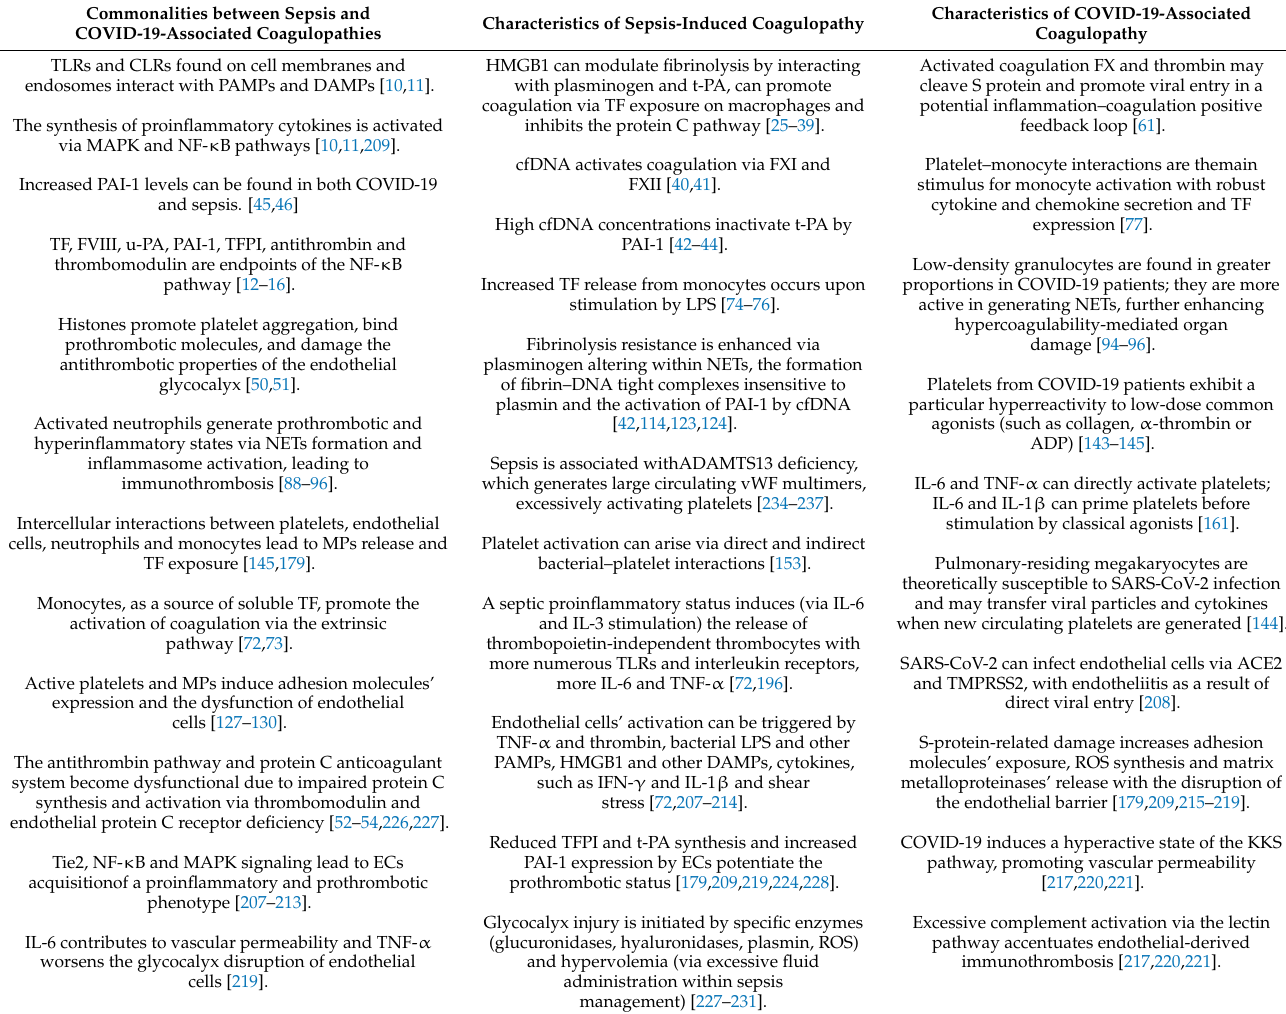
Table 1. Mechanisms of sepsis and COVID-19-associated